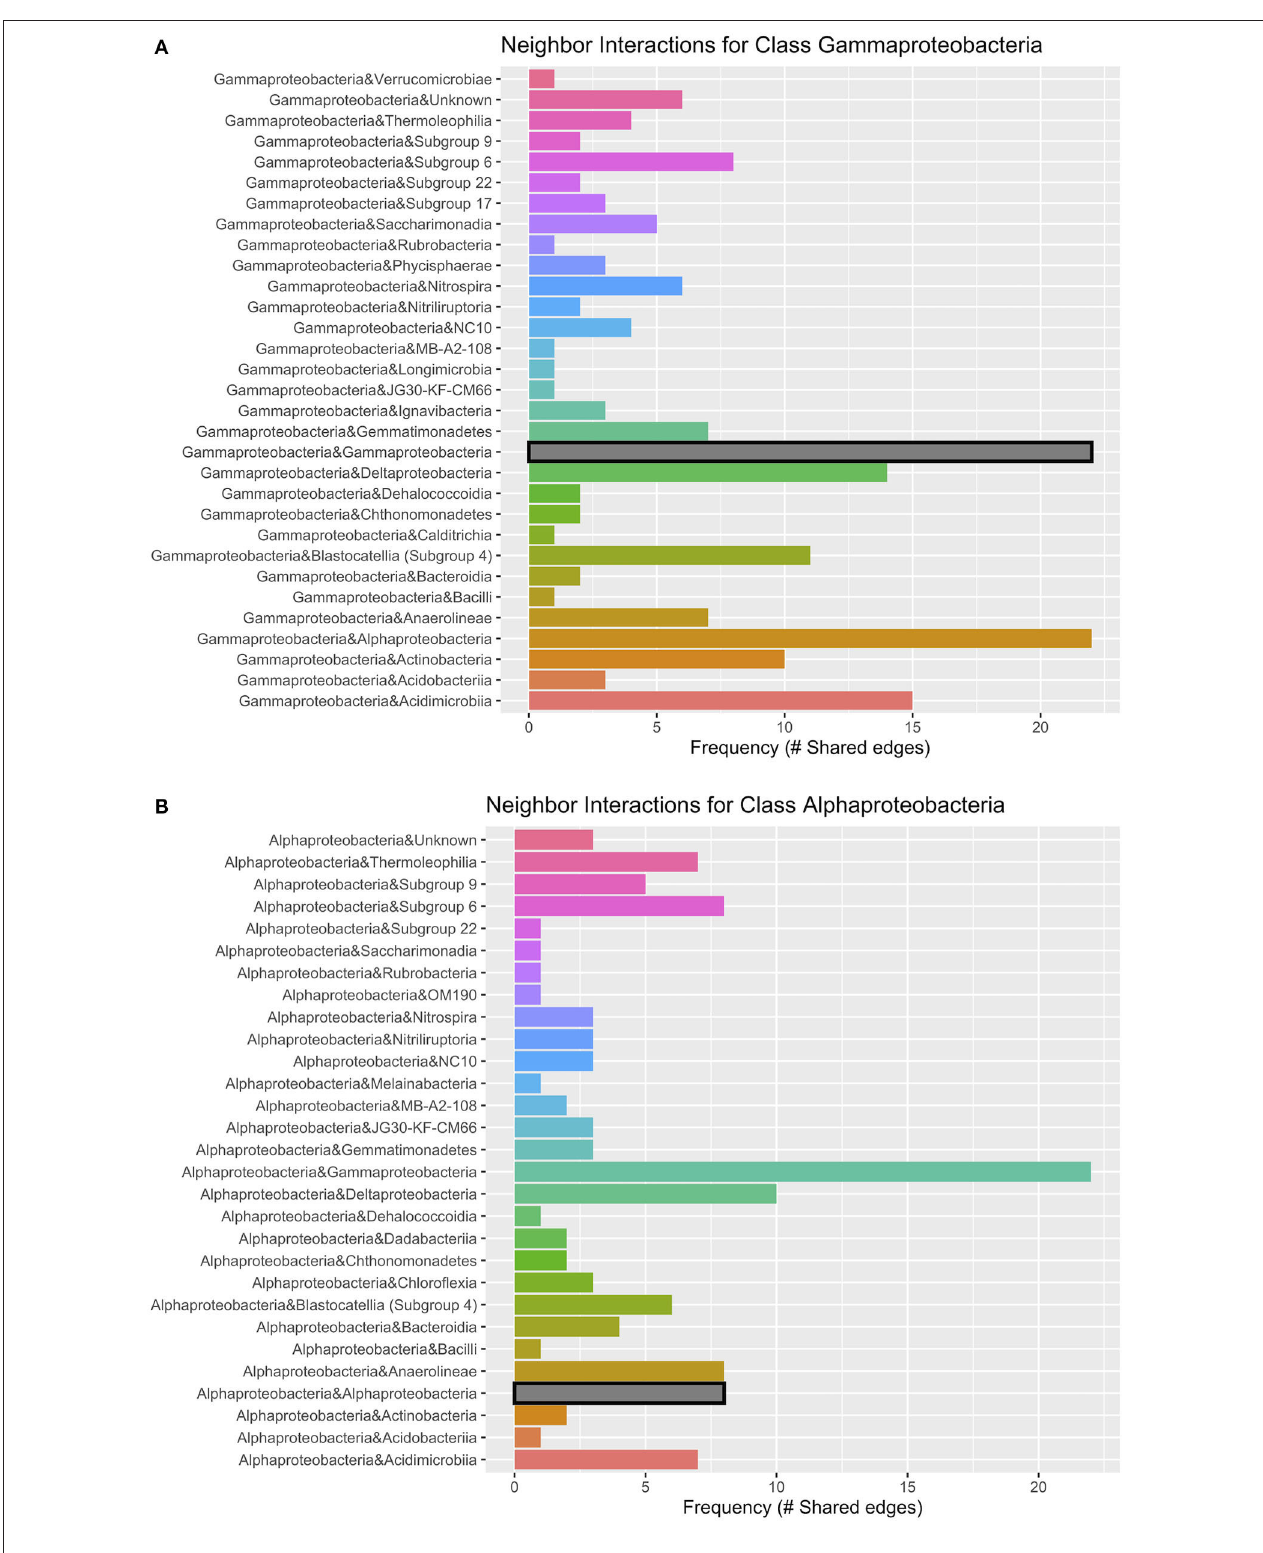
FIGURE 9 | Lava tube neighbor interaction frequency plots at the class level of the two classes with the greatest number of interactions (edges) within the network: (A) Gammaproteobacteria and (B) Alphaproteobacteria. Gammaproteobacteria have the highest frequencies of neighbor interactions with other Gammaproteobacteria, as well as Alphaproteobacteria. Gammaproteobacteria also interact or co-occur with Acidimicrobiia (phylum Actinobacteria), and Deltaproteobacteria. Alphaproteobacteria co-occur with Gammaproteobacteria at the greatest frequency and have much fewer interactions with other Alphaproteobacteria. Deltaproteobacteria and Chloroflexi class Anaerolineae also had a high frequency of interactions with Alphaproteobacteria within lava tubes.